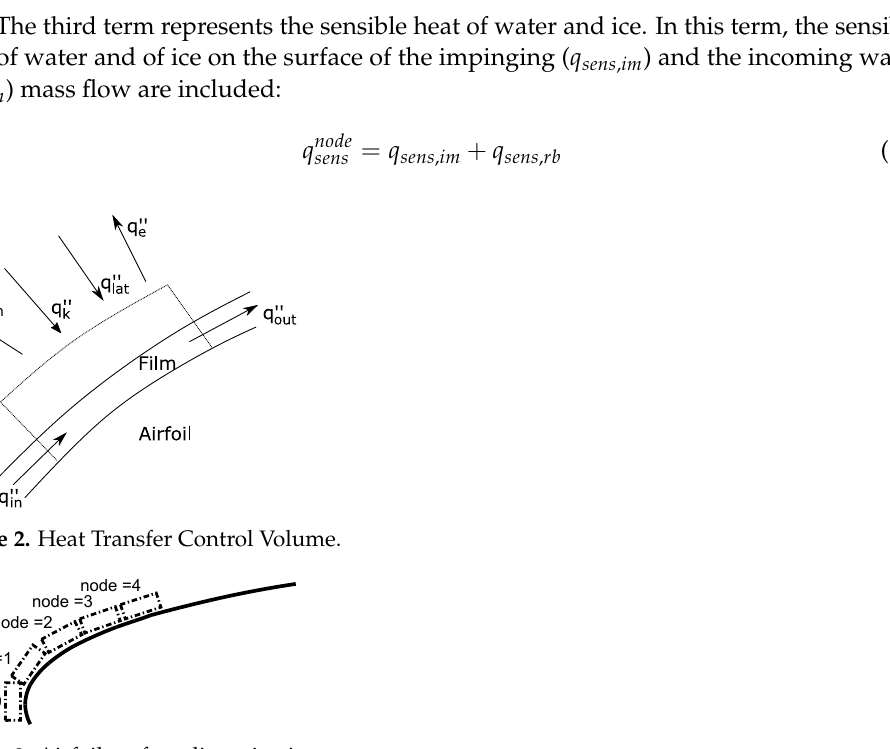
Figure 3. Airfoil surface